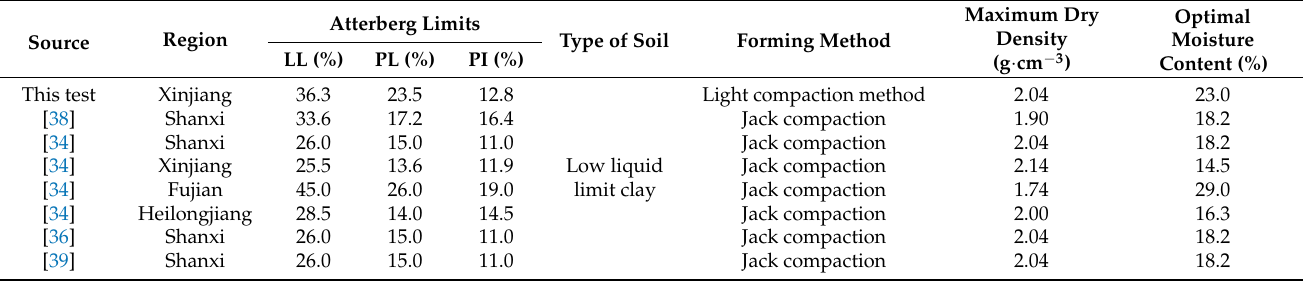
Table 6. Related literature and basic physical properties of earth